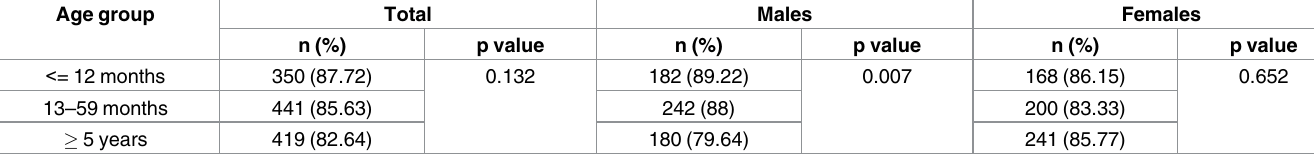
Table 1. Anemia prevalenceby age group and sex in children, Bata district, June-August 2013. Age group